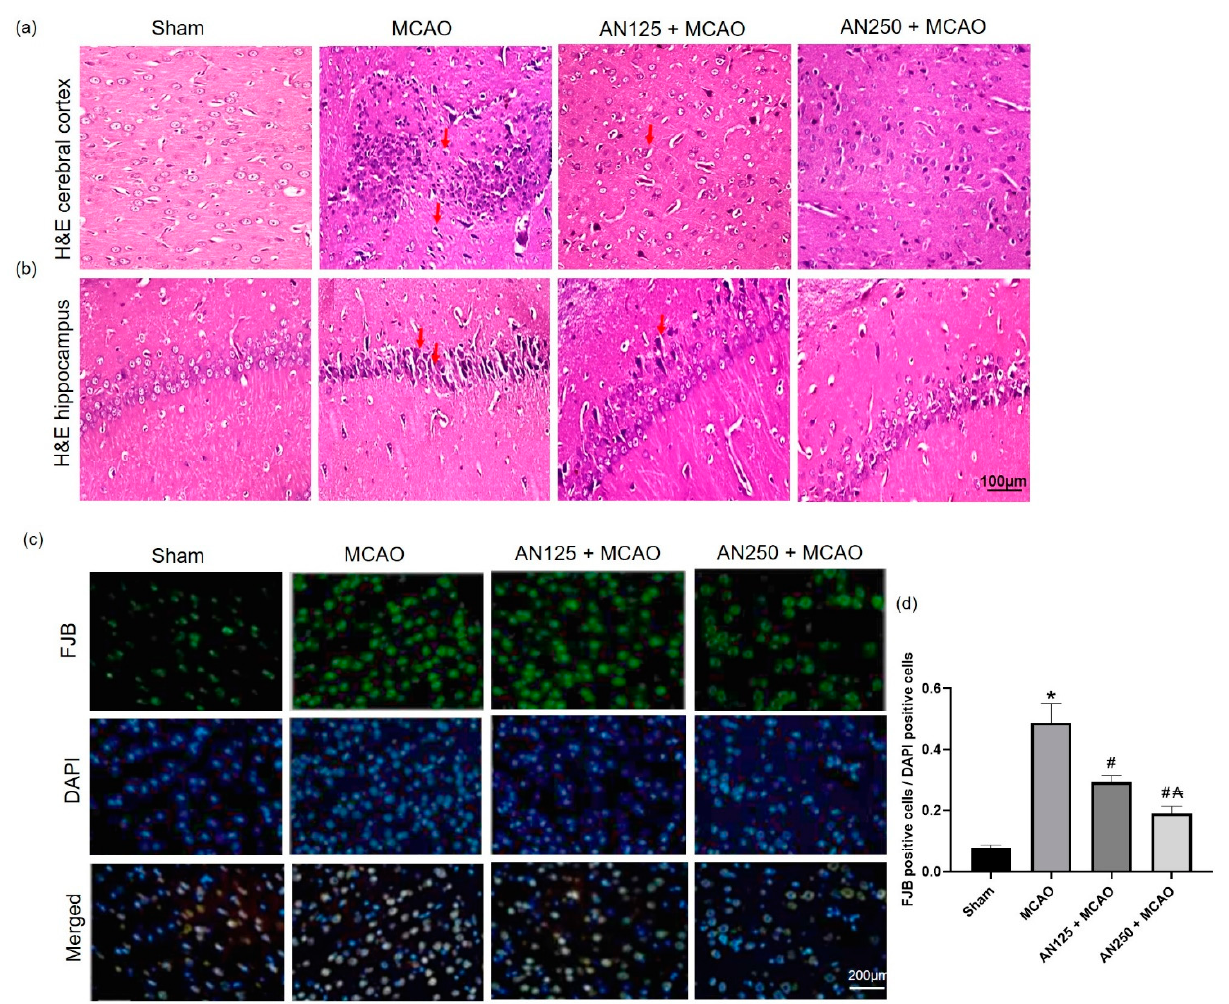
Figure 2. The impact of pretreatment with anethole (AN, 125, 250 mg/kg, orally) for two weeks in MCAO-induced cerebral ischemia/reperfusion on histopathology changes in penumbra area of ( a ) the cortex and ( b ) hippocampus neurons using H&E (×400) and on ( c ) Fluoro-Jade B stained neuronal degeneration and ( d ) FJB positive cells/DAPI positive cells. Data are expressed as mean ± SD ( n = 6). * significantly different from the sham-operated group, # significantly different from the MCAO ischemic group, and ₳ significantly different from the AN125 + MCAO group at p < 0.05 using ANOVA followed by Tukey ’ s post hoc